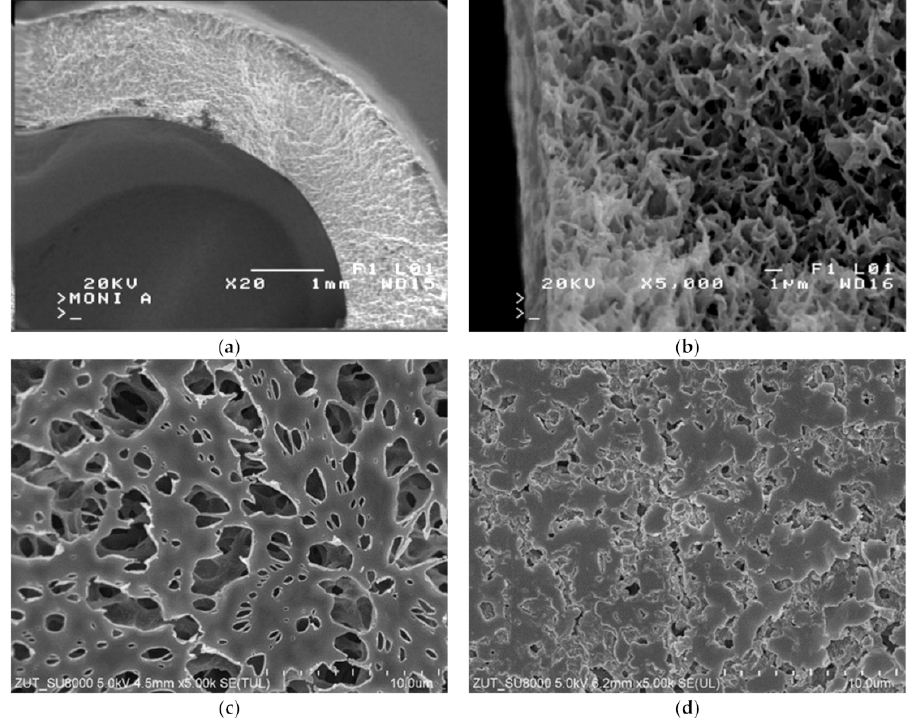
Figure 6. SEM images of Accurel PP V8/2 membrane: ( a ) membrane cross-section; ( b ) pore structure inside membrane wall; ( c ) internal membrane surface of virgin membrane; ( d ) membrane after separation of oil–water